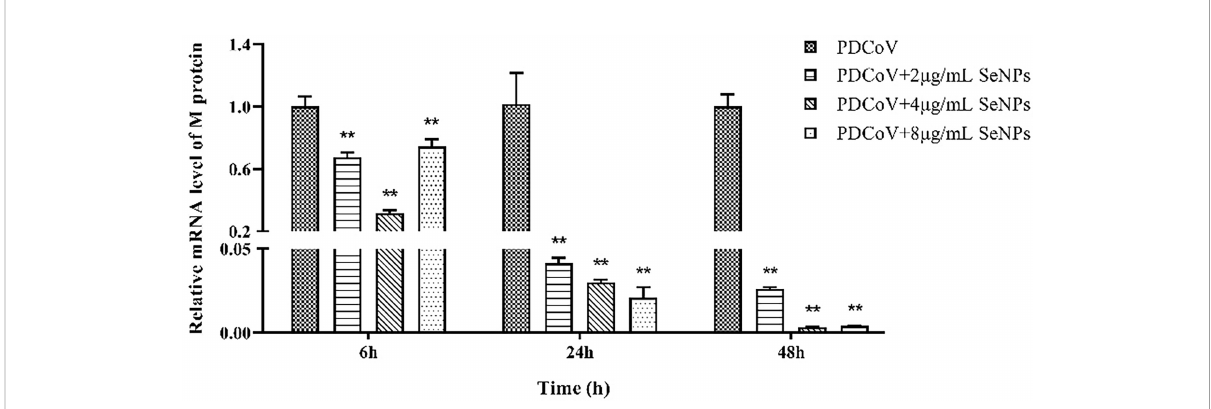
FIGURE 7 Effects of different concentrations of SeNPs on PDCoV replication in ST cells. ** indicates an extremely signi fi cant difference between different concentrations of SeNPs treatment group and PDCoV group (P <; 0.01), and no indication indicates no signi fi cant difference ( P > 0.05),